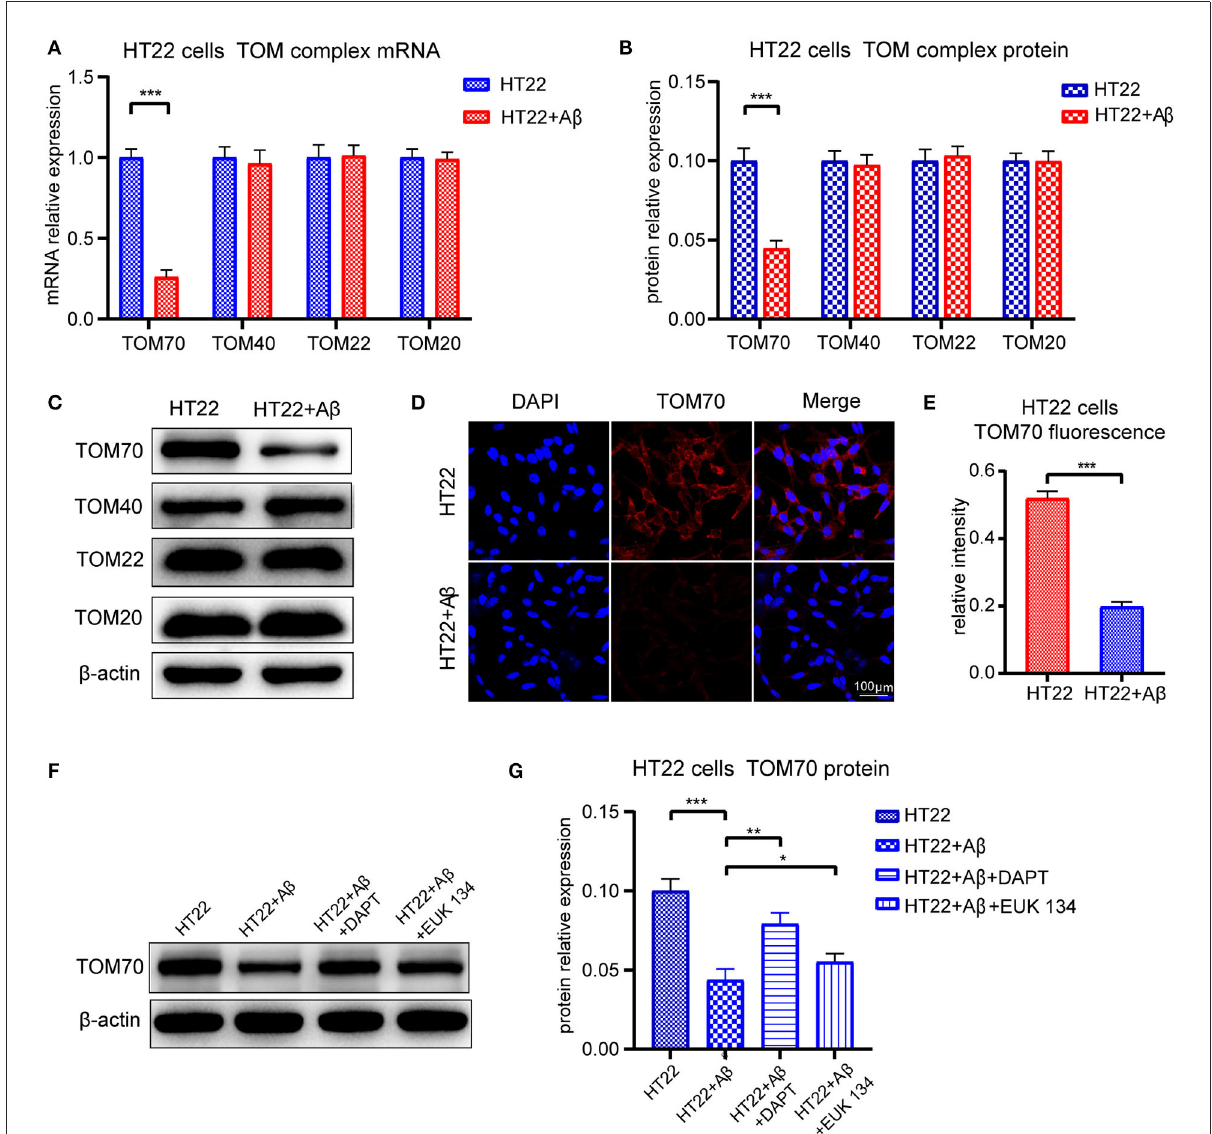
FIGURE7 Expression of TOM complex in HT22 cells treated with A β for 24h. Cells were treated with 20 µ M A β 25 − 35 for 24h, with or without followed by treating with 5 µ M DAPT or 20 µ M EUK 134 for 24h. (A) TOM70, TOM40, TOM22, and TOM20 mRNA levels in HT22 cells after 24-h treatment with A β 25 − 35 . (B) TOM70, TOM40, TOM22, and TOM20 protein levels in HT22 cells after 24-h treatment with A β 25 − 35 . (C) Representative bands of western blot of TOM complex in A β 2535-treated HT22 cells. (D) TOM70 fluorescence of HT22 cells treated with A β 25 − 35 for 24h. (E) TOM70 fluorescence relative intensity in HT22 cells after 24-h treatment with A β 25 − 35 . (F) Representative bands of western blot of TOM70 in A β 25 − 35 , DAPT, or EUK 134-treated HT22 cells. (G) TOM70 protein level in A β 25 − 35 , DAPT, or EUK 134-treated HT22 cells. * P < 0.05, ** P < 0.01, *** P <